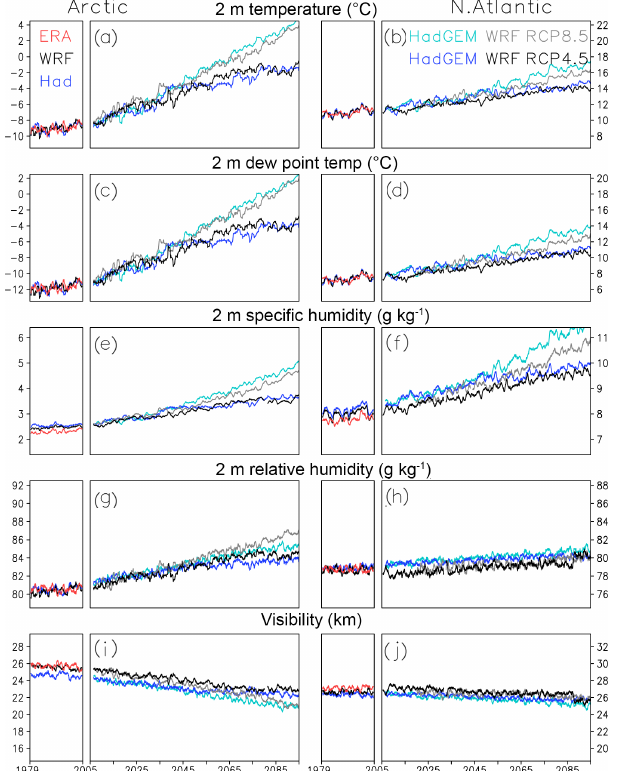
Figure 4. As in Fig. 2 but after a homogeneous two-step calibration of the WRF and HadGEM2 simulations to the analyzed ERA time series, which in turn is calibrated to the ICOADS collocations of the historical period